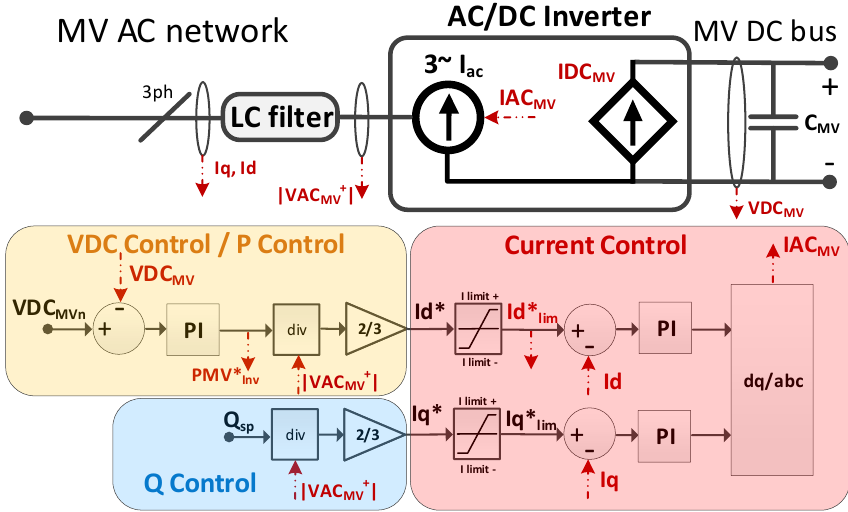
Figure 3. ST’s Medium Voltage Inverter and respective control structure. The active power flow in the MV inverter is modeled according to Equation (1), which determines the power transfer between the coupling LC filter and the MV DC bus. IDC MV is the DC current injected in the MV DC bus, PMV Inv and VDC MV are the active power and the DC voltage in the connection with the MV DC bus, v ab the phase–phase MV AC voltages (between phases a , b and c ) in the MV inverter, and i a i b and i c are the AC currents in the MV inverter’s phases a , b and c ( IAC MV ). VDC MV MV MV is determined according to Equation (2), where C MV is the capacitance of the MV DC bus, and IDAB MV , IDC MVg and I DL are the currents exchanged between the MV DC bus and the isolated DC/DC converter, the MV DC grid and the dump-load,